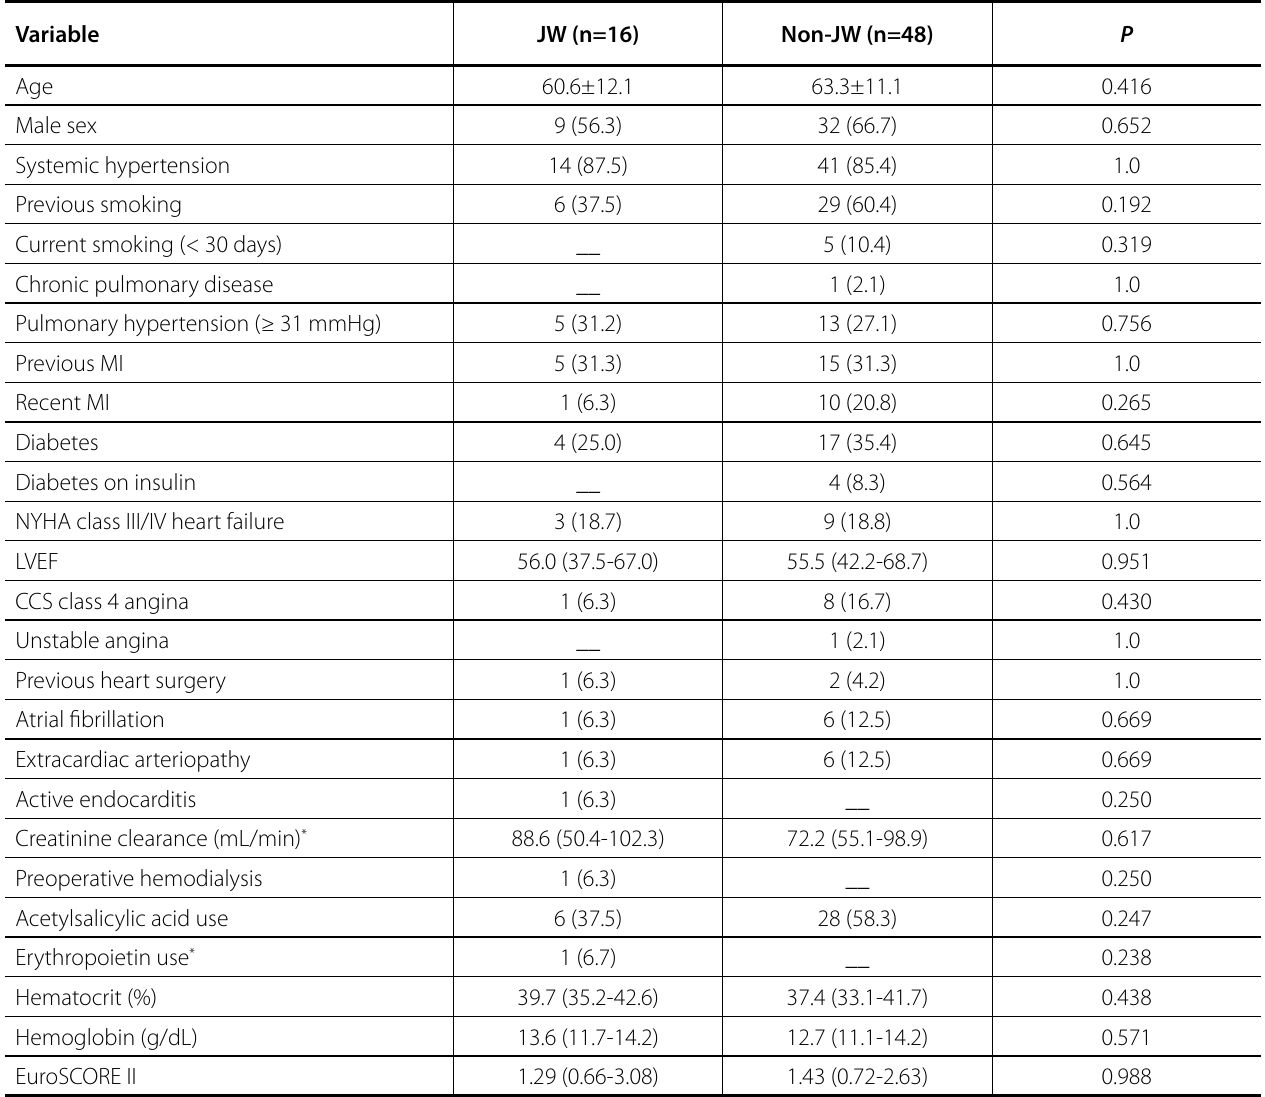
Table 1. Demographic characteristics of the